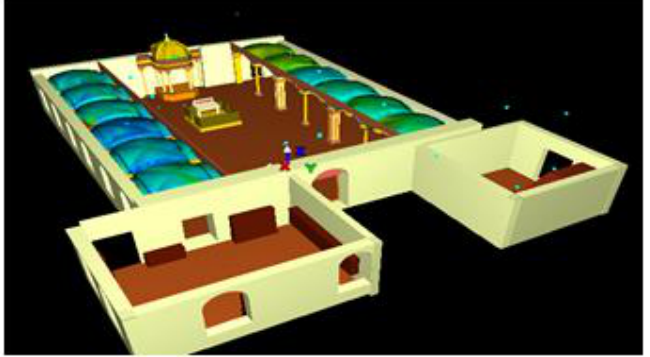
Figure 5. 3D model of the synagogue interior The accuracy of the resulting model was also analyzed using control reference measurements. The mean absolute differences between the lengths of chosen sections of the 3D model (edges) and the actual lengths of those sections did not exceed